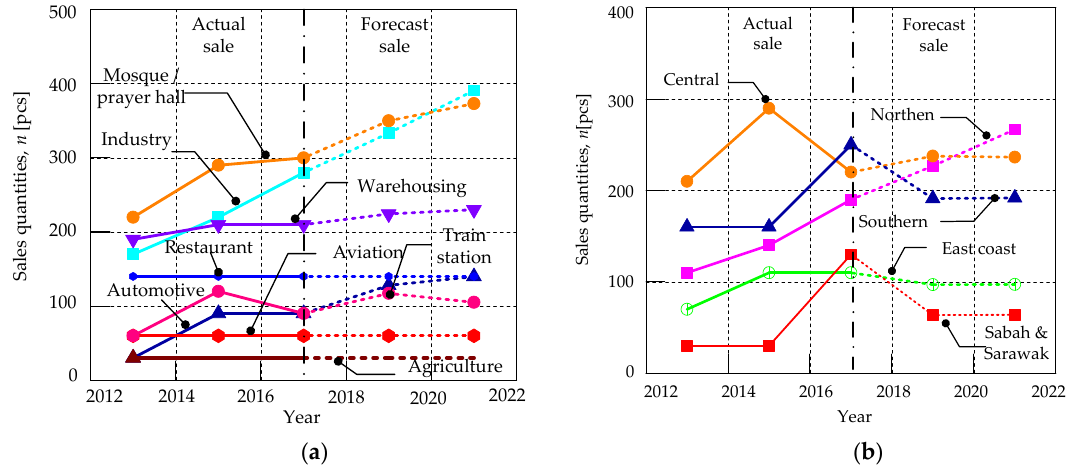
Figure 15. Market share forecasting ( a ) Market distribution ( b ) Market region .